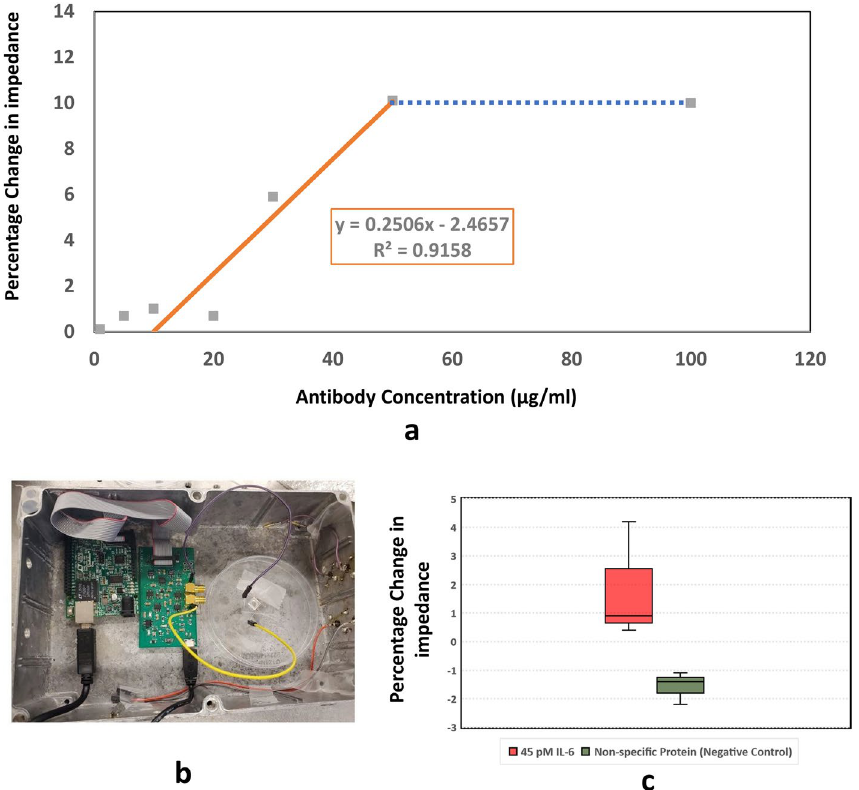
Figure 6. ( a ) Percentage Change in Impedance observed for the antibody adsorption experiments with different antibody concentrations. ( b ) Experimental Setup. From left to right: Controller board (Linduino- ATMega328 Processor), Custom PCB including frequency generation, lock-in amplification, and the 24-bit Analog-to-Digital Converter, Nanowell Array Impedance sensor on a petri dish. The experiments were performed with the metal box (acts as Faraday cage) with lid closed to reduce interference ( c ) Box plot of the experiment for protein detection in PBS. The experiments were repeated 3 times with 45 pM IL-6 and with non- specific protein i.e. SARS CoV-2